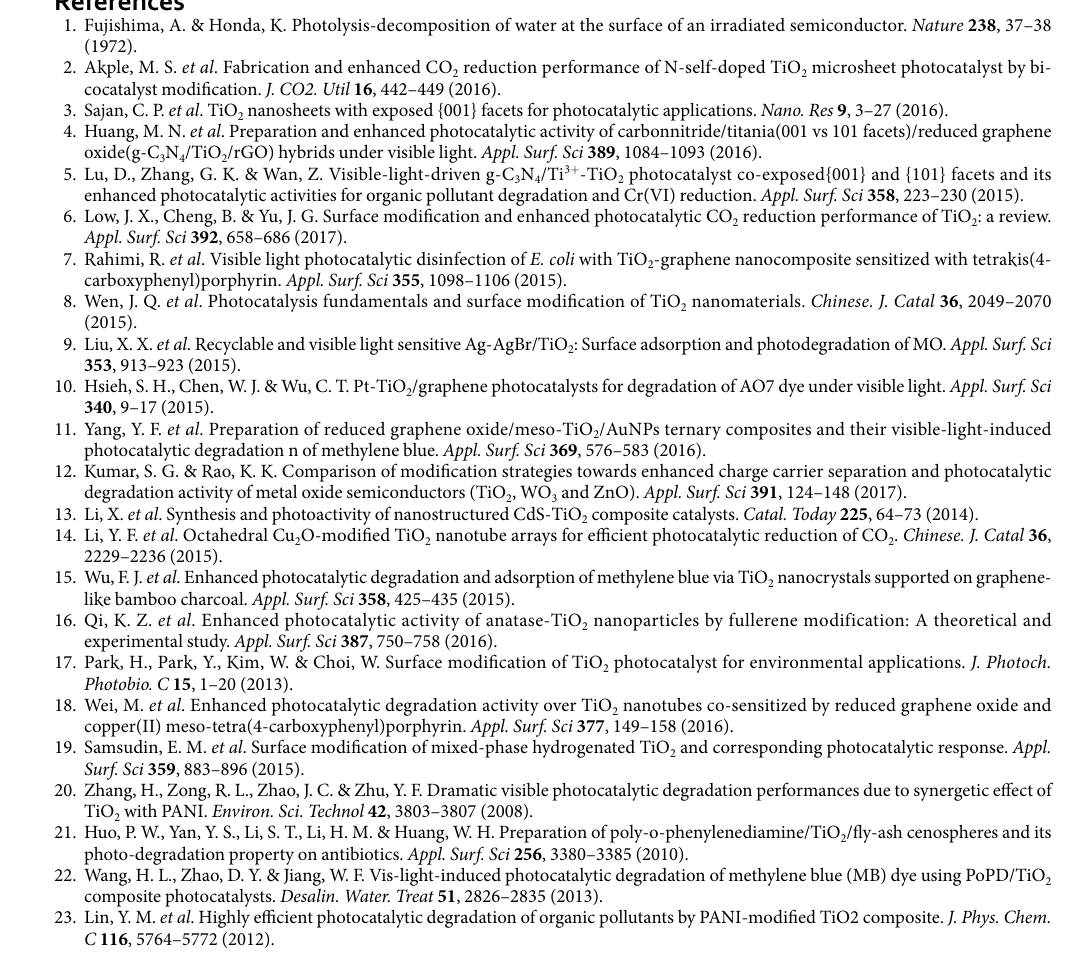
11 Scientific RepoRts | 7: 3973 | DOI:10.1038/s41598-017-04398-x